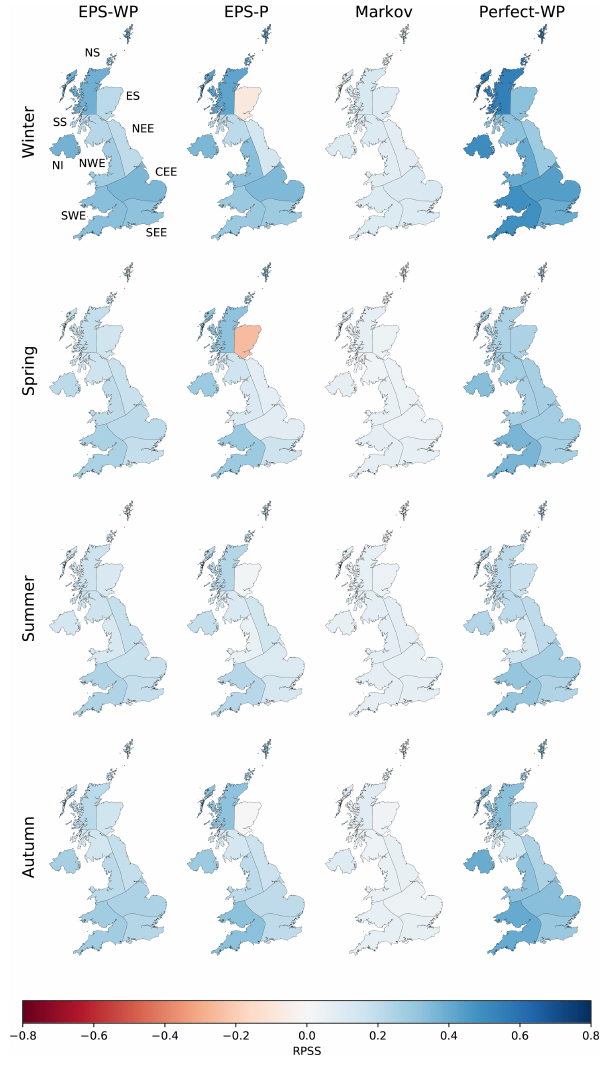
Figure 5. As Fig. 4 but for a 46d